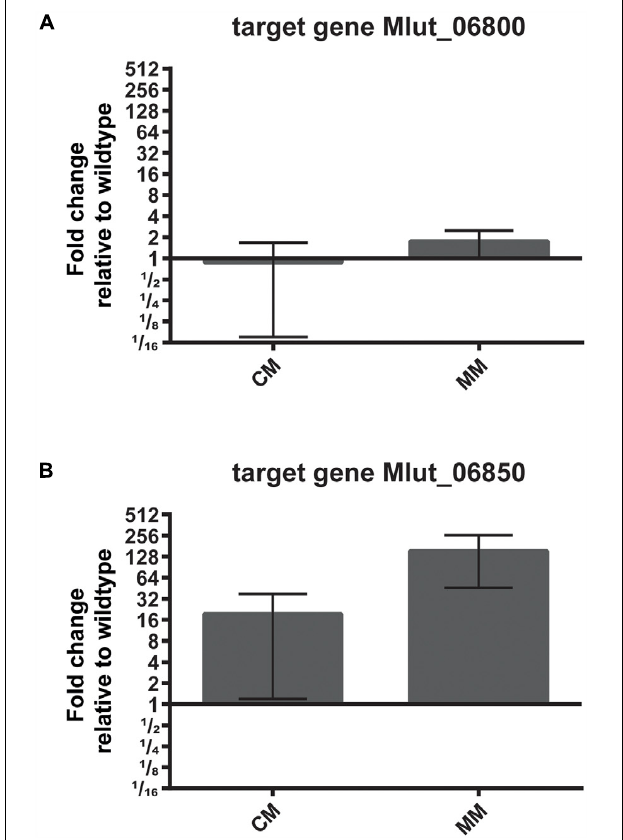
FIGURE 9 | Effect of deletion of the transcriptional regulator Mlut_06840 on the expression levels of Mlut_06800 (A) and Mlut_06850 (B) . Gene expression was measured by qPCR and is expressed relative to the parental strain, using the 2 − (cid:49)(cid:49) C T method. The mean of three technical replicates from two biological samples is shown, error bars are standard deviation. A log 2 -scale was employed on the y -axis. The strains were grown in complex medium (CM) or minimal medium